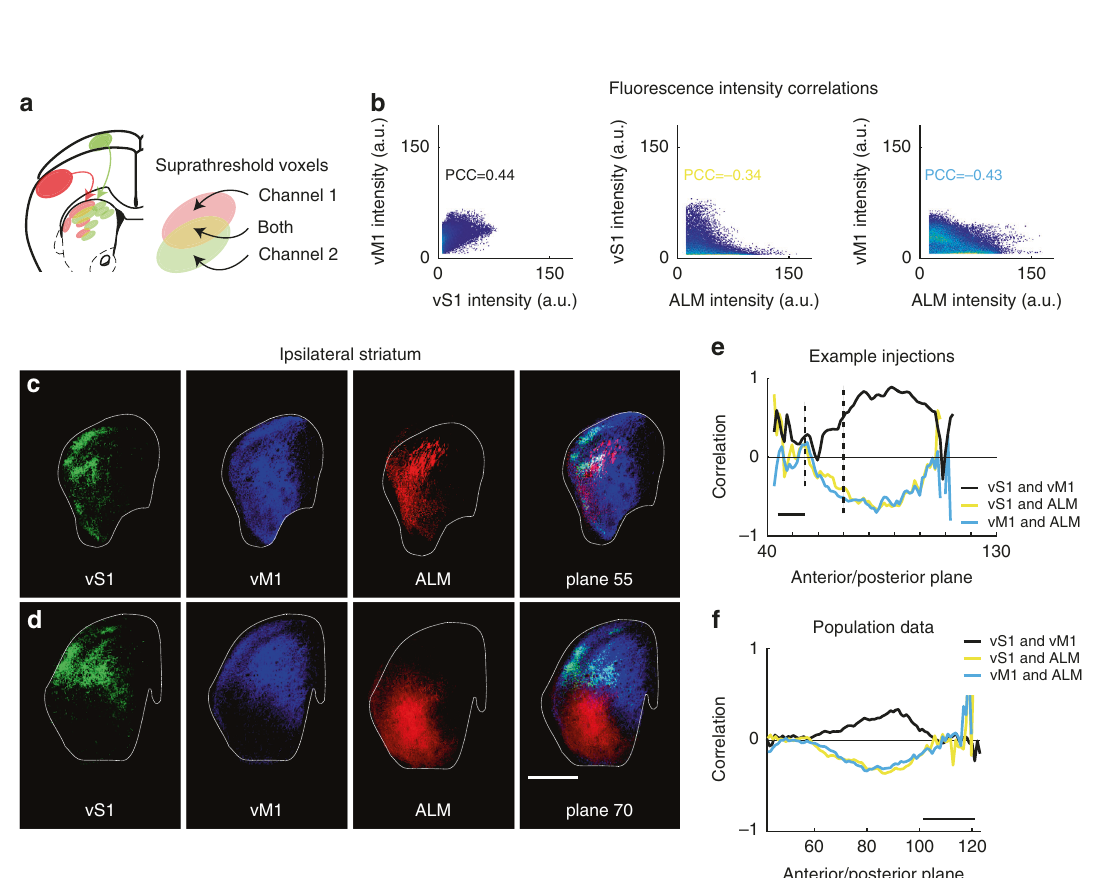
Fig. 1 Cre-driver mice label speci fi c pyramidal neuron types. a , b Coronal images of injection sites in Tlx3_PL56 (L5-IT) and Sim1_KJ18 (L5-PT) show somata locations. Scale, 0.5 mm. c Somata locations of Sim1_KJ18 mice injected in vM1, fM1, and S1. Comparison at right. N indicated shows # of sections (# of mice). Purple, vM1; burgundy, fM1; teal, vS1. Pia is relative laminar depth of 0; white matter is 1. Error bars represent SEM. Red tick marks show estimated cortical layers. d Mean somata distribution for lines labeling L2/3 (Sepw1_NP39), L5-IT (Tlx3_PL56), L5-PT (Sim1_KJ18), and L6 (Ntsr1_GN220). e Targets of IT-type (Tlx3_PL56) and PT-type (Sim1_KJ18) neurons, illustrated with single-axon reconstructions. IT-type neurons (blue) project to ipsi- and contralateral cortex (Ctx) and striatum (Str). PT-type neurons (gold) target ipsilateral cortex, striatum, and subcortical targets in thalamus (Thal), superior colliculus (SC) and brainstem. f – h Image of Sim1_KJ18 injection site. White box in f indicates magni fi ed area ( g , h ). Scale 0.5 mm. h Annotation of somata in Neurolucida. Blue circles indicate AAV-infected cell bodies expressing smFPs. i , j Coordinates of somata and fi ducial markers placed along pia and white matter of cortex were aligned to the CCF. Somata for three injections (teal, burgundy, and purple) and fi ducial markers (gray) were then plotted in 3-d (1 mm scale). Rotated projection ( j ) shows dorsal view of injection site center of mass (teal) and anterior/posterior spread of infection. (k) Injection site center of mass of Tlx3_PL56 ( N = 92, circles) and Sim1_KJ18 ( N = 62, triangles) plotted and spatially clustered. Eight clusters shown in red (M2), orange (ALM), purple (vM1), burgundy (fM1), green (llM1), yellow (fS1), teal (vS1), and gray (orfS1). Indeterminate injection sites are black. Sites are superimposed on an image of the dorsal surface of mouse cortex. Black cross marks midline and bregma. Scale, 1 mm